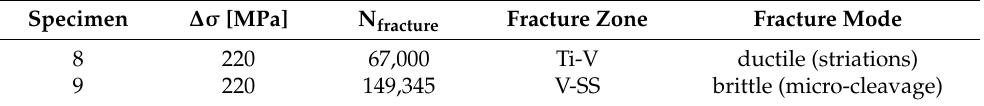
Table 8. Fracture details for specimens 8 and 9.